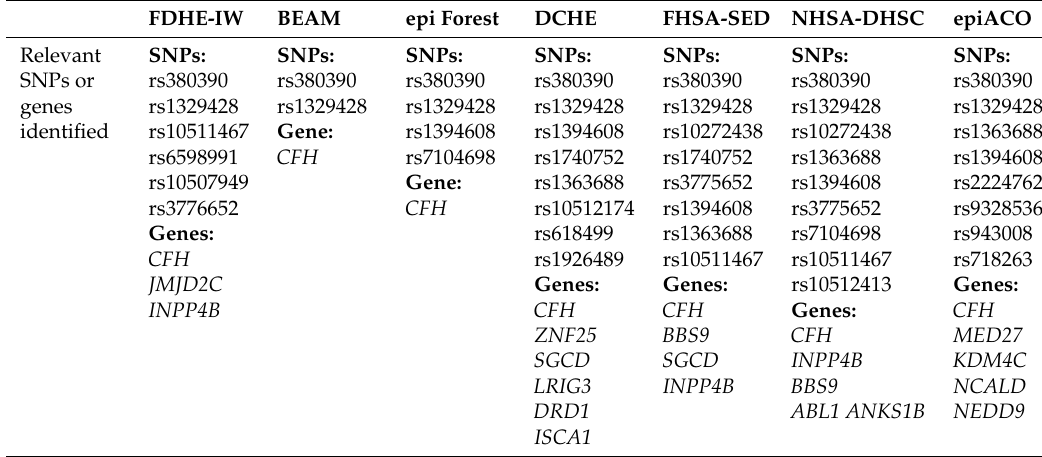
Table 6. Comparison of the results of seven algorithms using the age-related macular degeneration (AMD) data set. FDHE-IW BEAM epi Forest DCHE FHSA-SED NHSA-DHSC